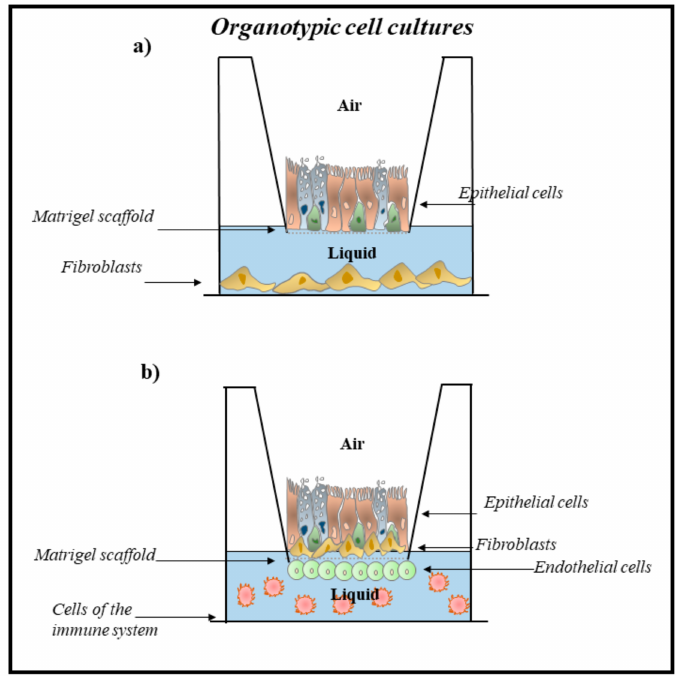
Figure 3. Two different 3D organ-typical cell cultures to study the effects of environmental contami- nants in airway diseases of the lung. ( a ) Three-dimensional (3D) cell culture model obtained with a co- culture of epithelial cells and fibroblasts; ( b ) Three-dimensional (3D) cell culture model obtained with multiple cell types from the pulmonary system (structural and inflammatory). Three-dimensional (3D) tetraculture system containing macrophages, epithelial cells, fibroblasts, and endothelial cells, mimicking lung